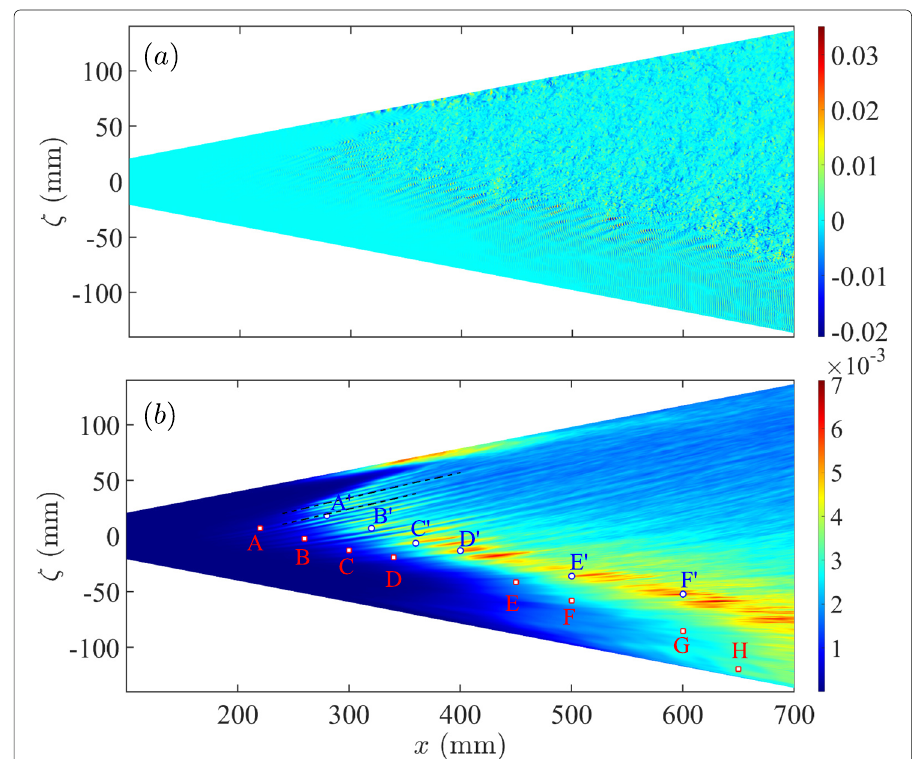
Fig. 5 The instantaneous a and r.m.s. b of the fluctuating wall pressure. The dashed lines in b represent the trajectories of stationary crossflow vortices shown in Fig. 4. The markers are probe points with those upstream and downstream of the transition front labeled as Group 1 and Group 2, respectively